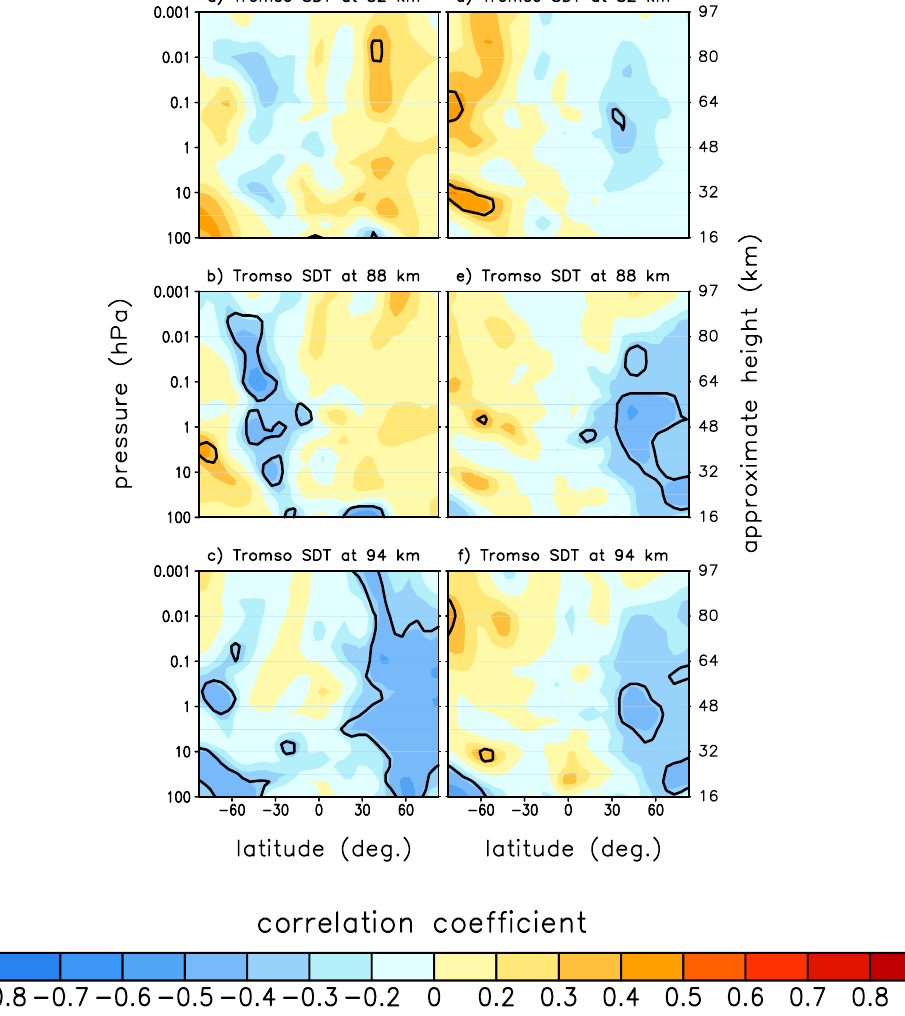
Fig. 3. Correlation coefficients between the stationary planetary wave 1 amplitude at each latitude/pressure with the meridional semidiurnal tide amplitudes observed at Tromsø (70 ◦ N, 19 ◦ E) for 30 June–27 October 2006 (left column) and for 30 June–27 October 2007 (right column). Otherwise details are as in Fig.